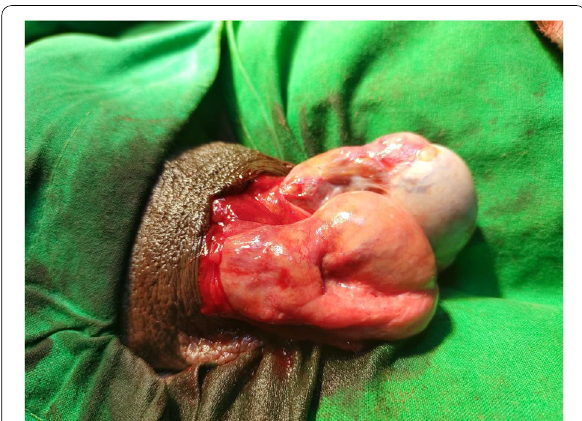
Fig. 1 Scrotal exploration revealing non-viable and inflamed right testis Fig. 2 Scrotal exploration revealing partially viable right